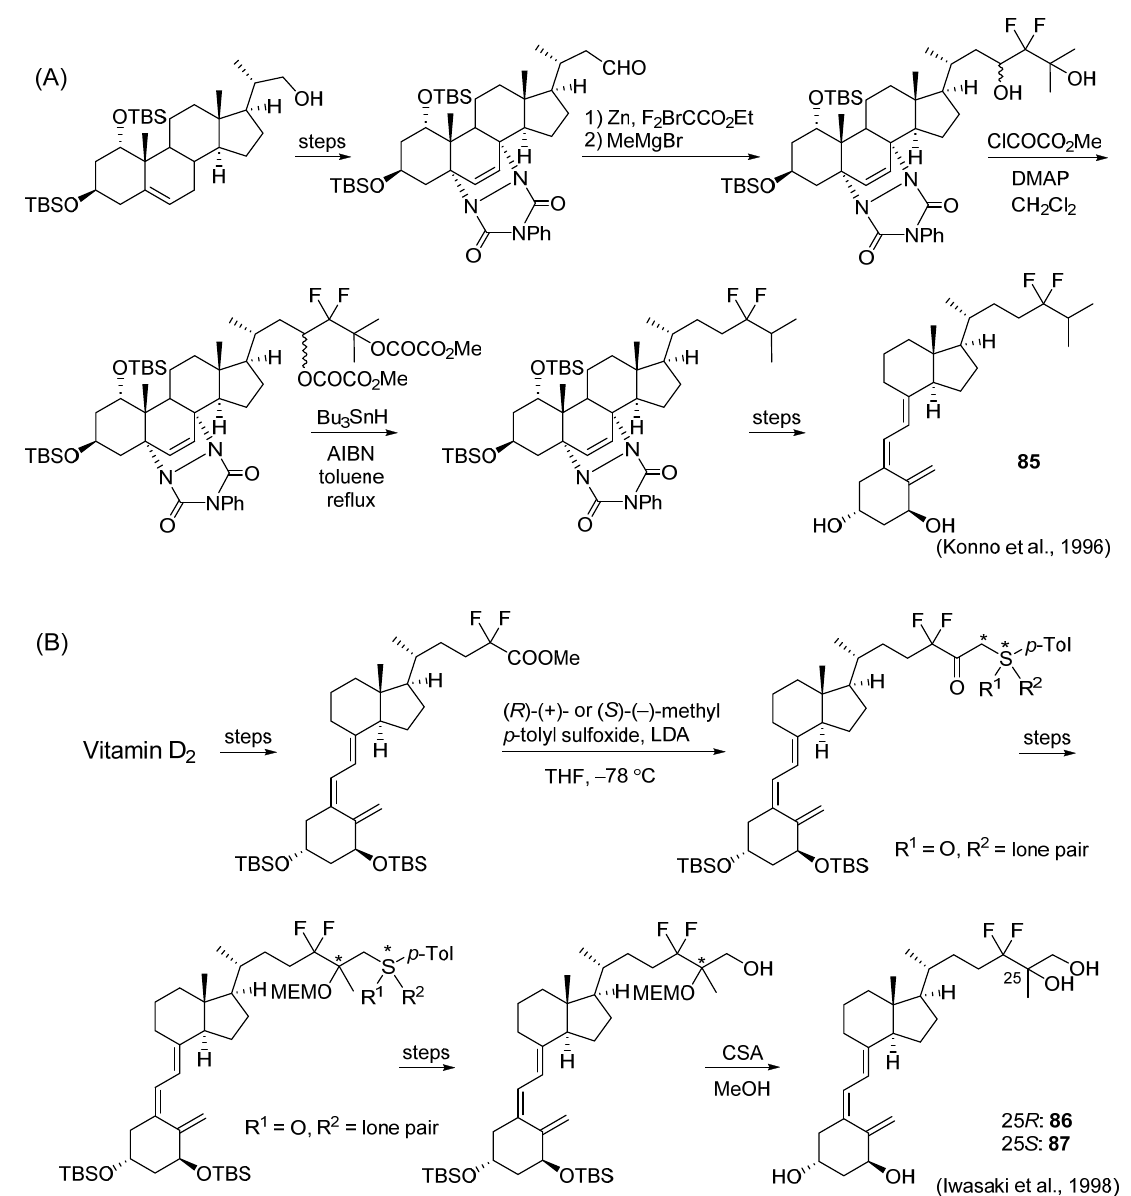
The 24,24-difluoro-19-norVD 3 analogues including 20- epi -versions ( 88 – 91 ) were re- ported by DeLuca et al. in 2015 [62]. In contrast to the previous synthetic methods starting from steroid skeletons, they demonstrated a convergent method utilizing the Wittig– Horner reaction between 24,24-difluoro-CD-rings ( 92 , 93 ) and a lithium salt of a phosphine oxide anion from A-ring precursors (Scheme 30). The 20 S -derivatives showed marked bone-mobilizing activity in vivo; however, 2-methylene substitution was required for such elevated activity in the 20 R